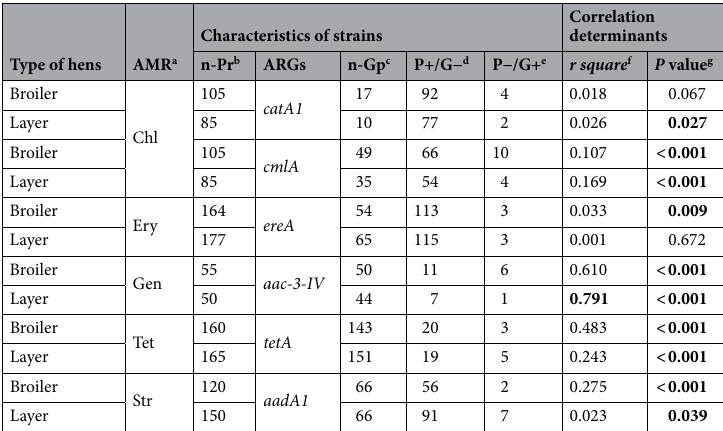
Table 10. Correlation between the AMR phenotypes and genotypes among the investigated E. coli ( n = 381) isolates in relation to the type of hens (broiler or layer). a Chl Chloramphenicol, Ery Erythromycin, Gen Gentamicin, Tet Tetracycline, Str Streptomycin. Please note that the correlation between trimethoprim- sulfonamide and sul1 was not included in this table because sul1 is responsible for resistance to sulfamethoxazole only not to the trimethoprim-sulfonamide combination. b n-Pr: number of strains expressing phenotype resistant to the indicated antimicrobial agent. c n-Gp: number of strains carrying the indicated resistance gene. d P+/G−: number of phenotypically resistance strains (P+) with no resistance genes (G−) for the antimicrobial identified. e P−/G+: number of phenotypically susceptible strains (P−) with one or more resistance genes (G+) for antimicrobials. f r square = 1 indicates positive correlation, r square = 0 indicates no correlation. The highest correlation obtained is highlighted in bold. g P values < 0.05 are highlighted in